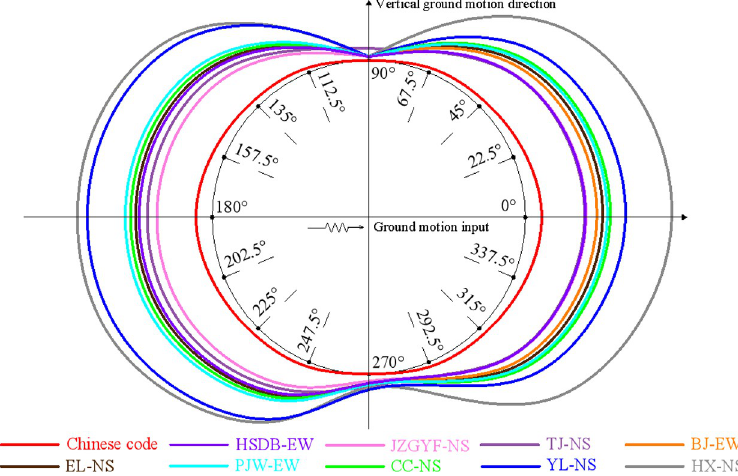
Fig 13. Maximum hydrodynamic pressure distributions in the circumferential direction at the tank bottom at 1.0 m/s 2 peak acceleration for the A-50% condition.